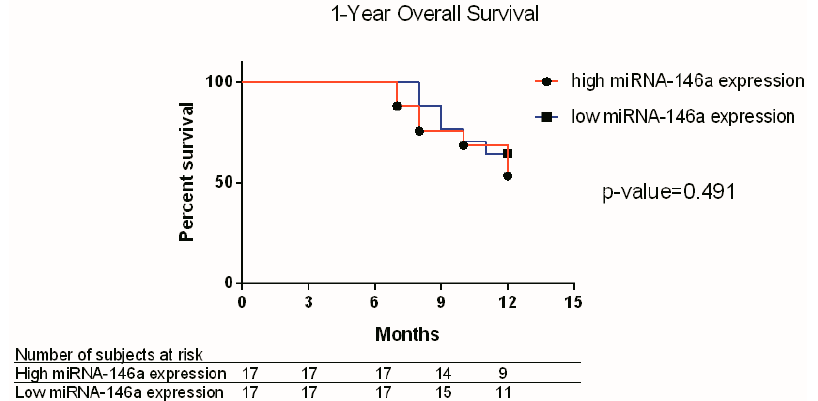
Figure 3. The Kaplan–Meier analysis of high and low miRNA-146a expression level groups of ccRCC patients after ICI therapy. p -value was calculated using Gehan–Breslow–Wilcoxon test.